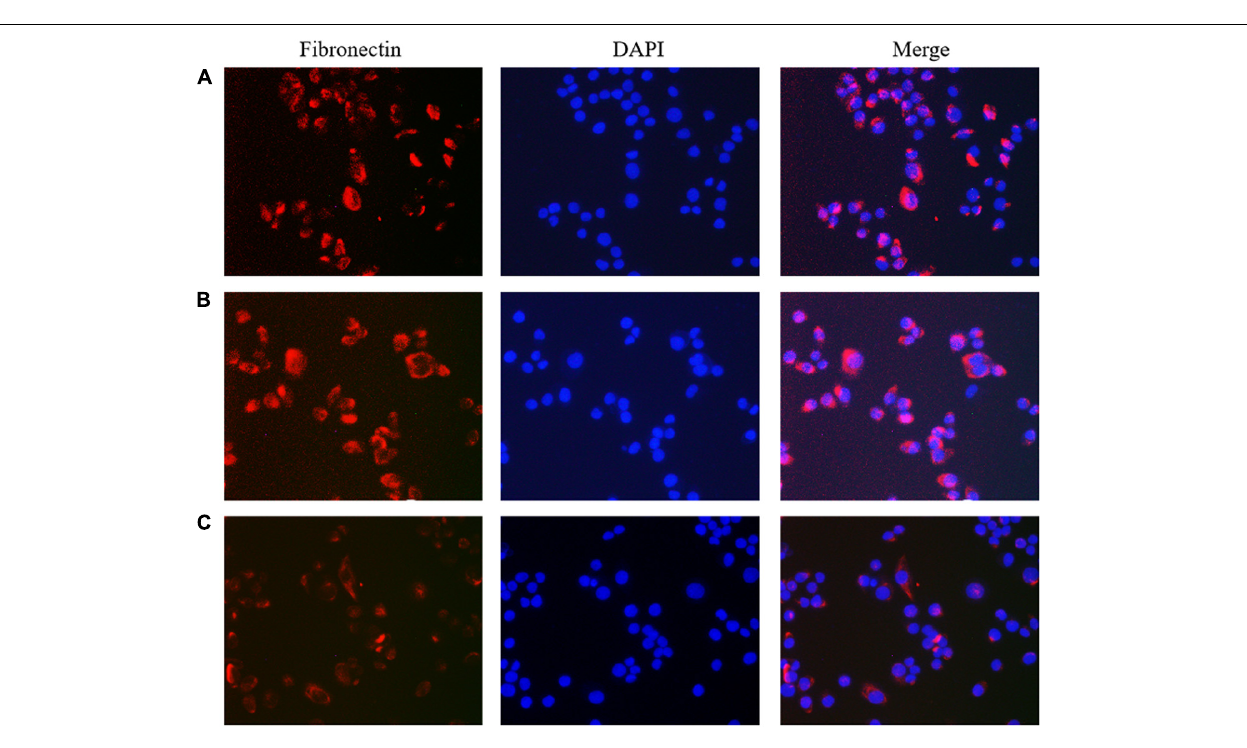
Frontiers in Cell and Developmental Biology |